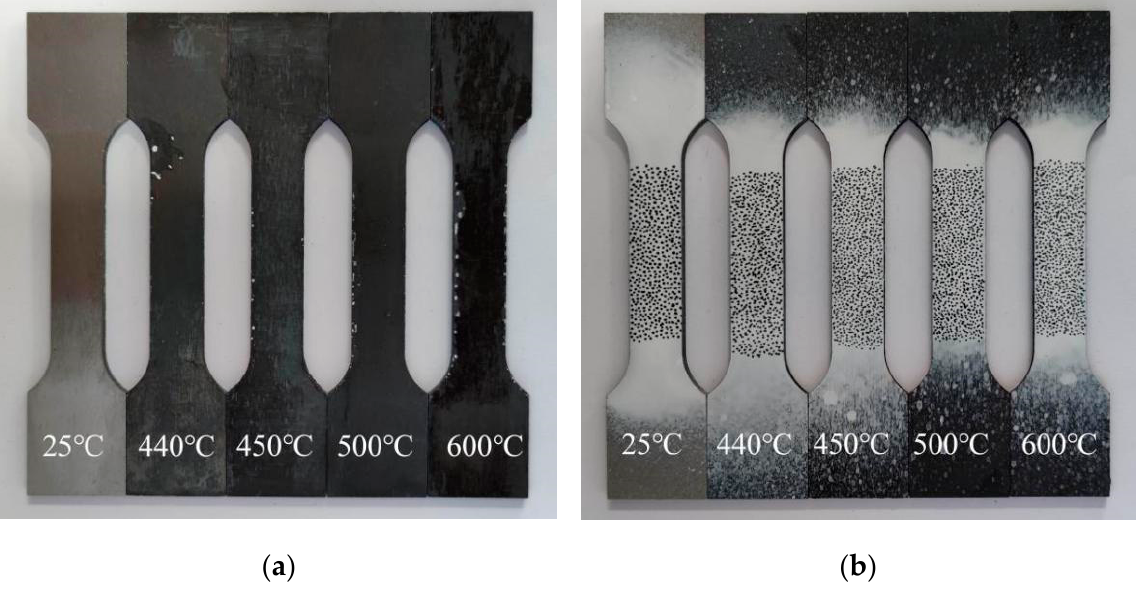
Figure 9. Specimens display diagram. ( a ) The specimen after heat treatment; ( b ) The specimens after spraying speckle.